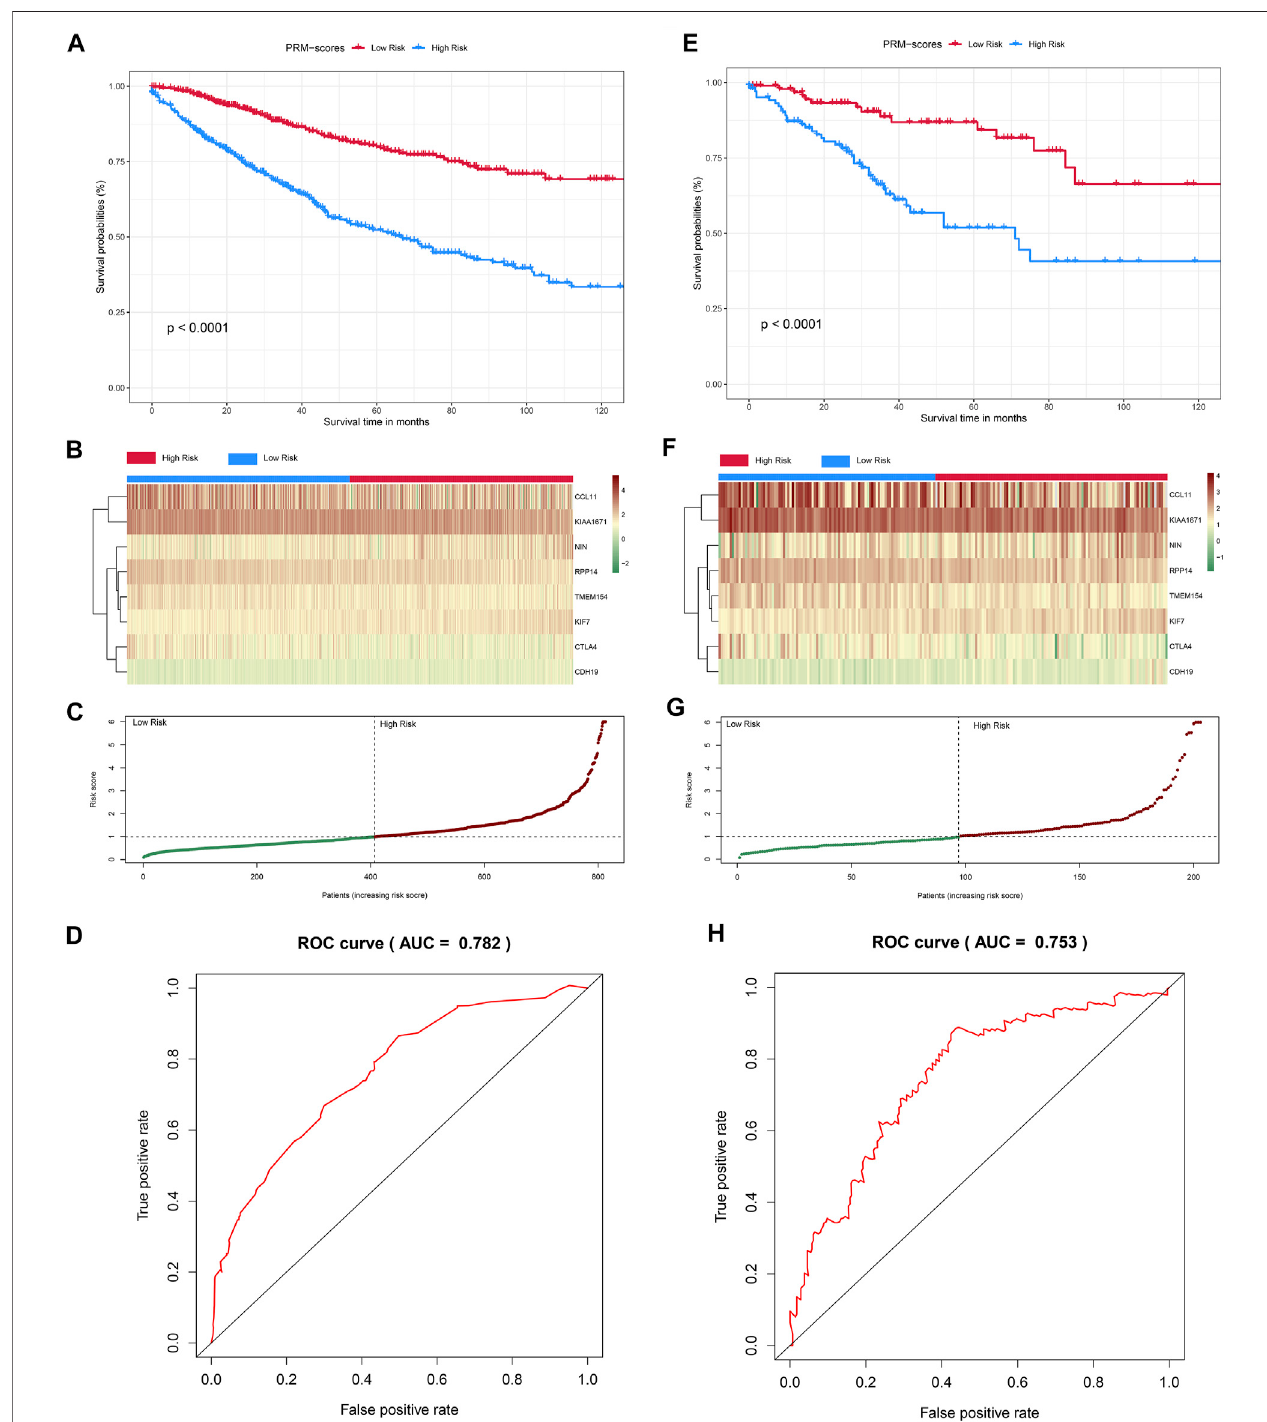
FIGURE 5| Construction and validation of the PRM-scores in colon cancer cohorts. (A) Kaplan – Meier curvesfor the overall survival(OS) of colon patients in inner- training cohort between the high- and low-PRM-scores groups based on GSE39582, GSE33113, and The Cancer Genome Atlas — Colon Adenocarcinoma (TCGA- COAD) data (log-rank test, p < 0.01). (B, C) Distribution of PRM-scores and the expression of eight signatures related to three pyroptosis-related (PR) clusters in inner- training cohort. (D) receiver operating characteristic (ROC) curves demonstrated the predictive ef fi ciency of the PRM-scores in inner-training cohort. (E) Kaplan – MeiercurvesfortheOSofcolonpatientsinvalidationcohortbetweenthehigh-andlow-PRM-scoresgroups(log-ranktest, p < 0.01). (F,G) DistributionofPRM- scoresandtheexpressionofeightsignaturesrelatedtothreePRclustersinvalidation cohort. (H) ROCcurvesdemonstratedthepredictiveef fi ciencyofthePRM-scores in validation